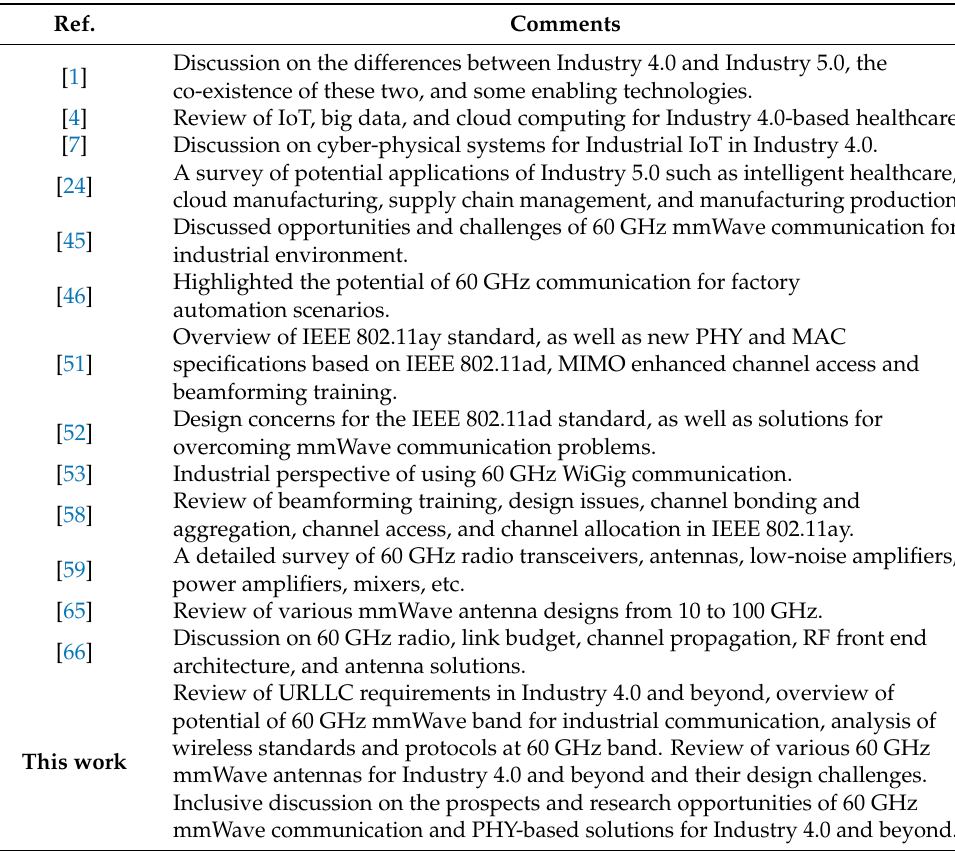
Table 1. Comparison of the related contributions of selected literature at 60 GHz band.